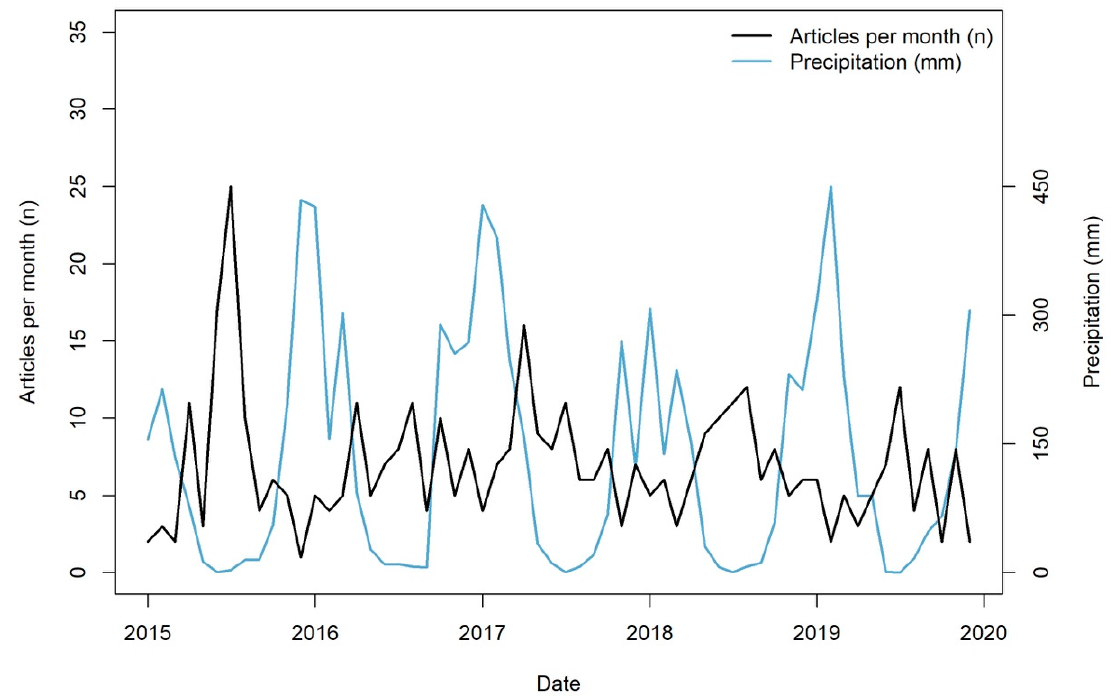
Figure 4. Time-series of published news articles discussing cannabis and water in the ET-CA grouped by month and year.